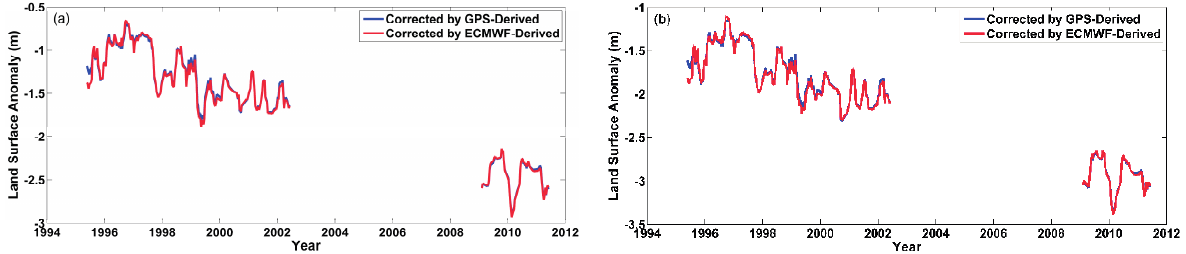
Figure 8. Retracked altimetric LSAs corrected by GNSS- and ECMWF-derived wet troposphere delays in Yuanchang; ( a ) retracking by MTR; ( b ) retracking by STR. Blue and red curves represent the corrections of GNSS- and ECMWF-derived delays,